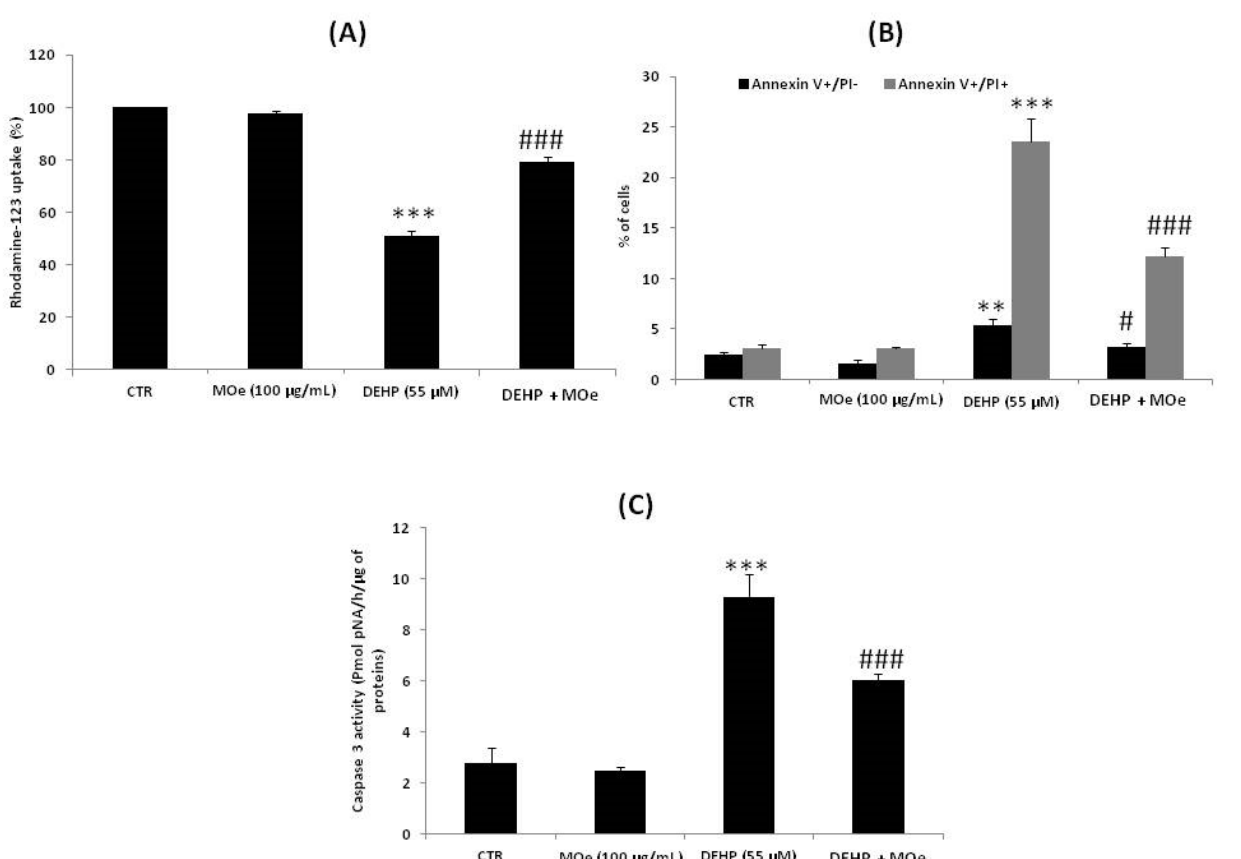
Figure 8. ( A ) Effect of MOe on DEHP-induced loss of mitochondrial membrane potential. SH-SY5Y cells were pretreated with MOe (100 µ g/mL) for 2 h before DEHP treatment for 24 h (55 µ M). After treatment, the mitochondrial potential was evaluated by the Rhodamine-123 uptake measurement. ( B ) Effects of MOe on DEHP-induced cell apoptosis. Distinct subsets of cells were detected by AnnexinV/ Propidium iodide (PI) staining after treatment with DEHP (55 µ M) and/or MOe (100 µ g/mL). Early apoptotic cells are positive for AnnexinV and negative for PI (AnnV+/PI − ) and late apoptotic/necrotic cells are both positive for AnnexinV and PI (AnnV+/PI+). ( C ) Effect of MOe on DEHP-induced caspase-3 activation. SH-SY5Y cells were pretreated with MOe (100 µ g/mL) for 2 h before DEHP treatment for 24 h (55 µ M). Caspase-3 activity was measured using a commercialized kit. Data are expressed as the mean ± SD of three separate experiments. ** p < 0.01, *** p < 0.001 vs. control, and # p < 0.05, ### p < 0.001 vs. DEHP alone.